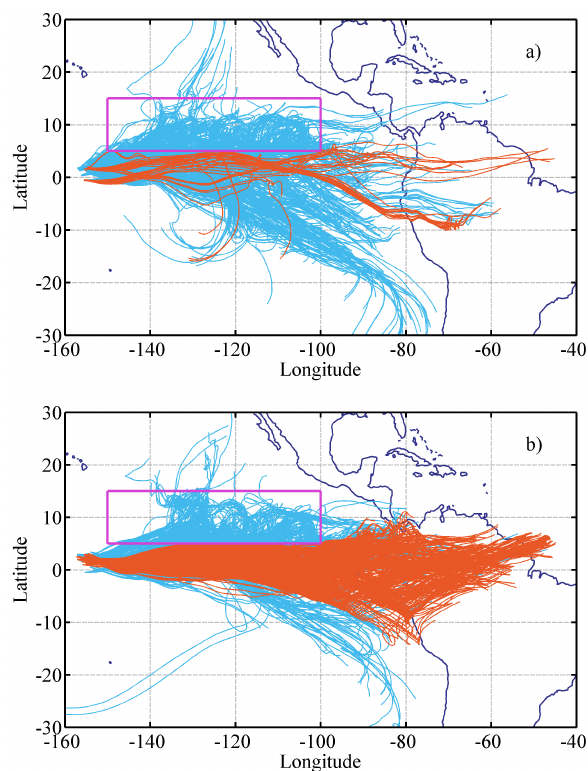
Fig. 5: Back trajectories associated with distinct air mass fea- Fig. 5. Back trajectories associated with distinct air mass features tures observed during PASE for (a) convective cloud outflow observed during PASE for (a) convective cloud outflow and (b) pol- lution. The magenta rectangle identifies the region of heaviest deep and (b) pollution. The magenta rectangle identifies the re- convection (ITCZ) during PASE. Trajectories marked in blue pass gion of heaviest deep convection (ITCZ) during PASE. Tra- through the magenta rectangle, while those colored orange bypass jectories marked in blue pass through the magenta rectangle, the “ITCZ” while those colored orange bypass the “ITCZ” box.